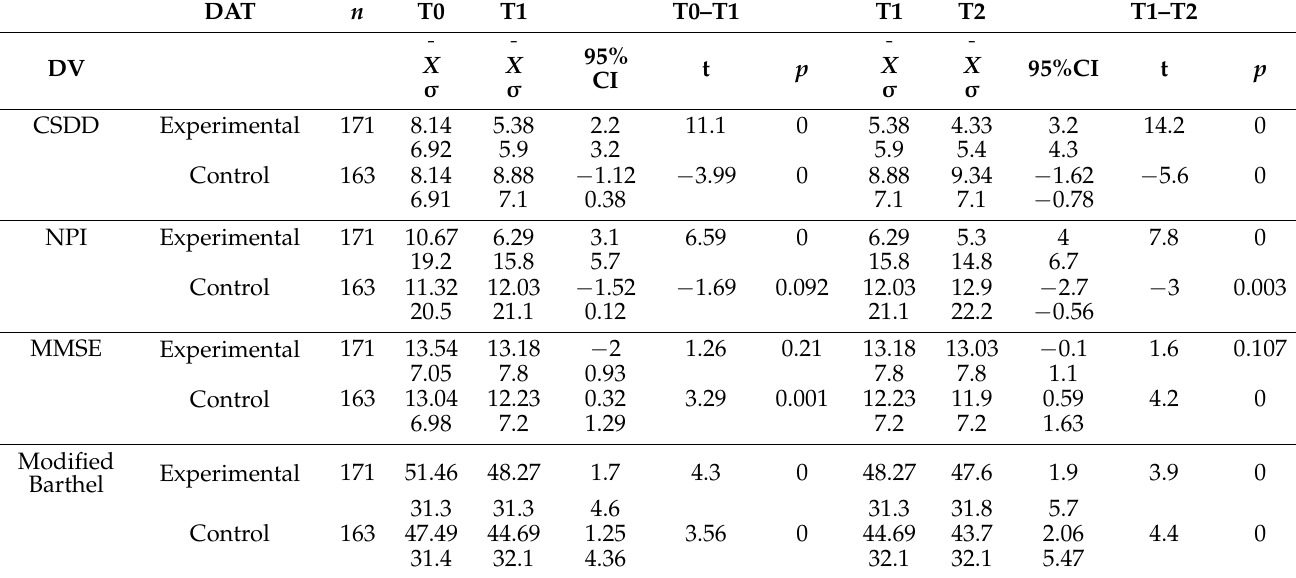
Table 2. Evolution of